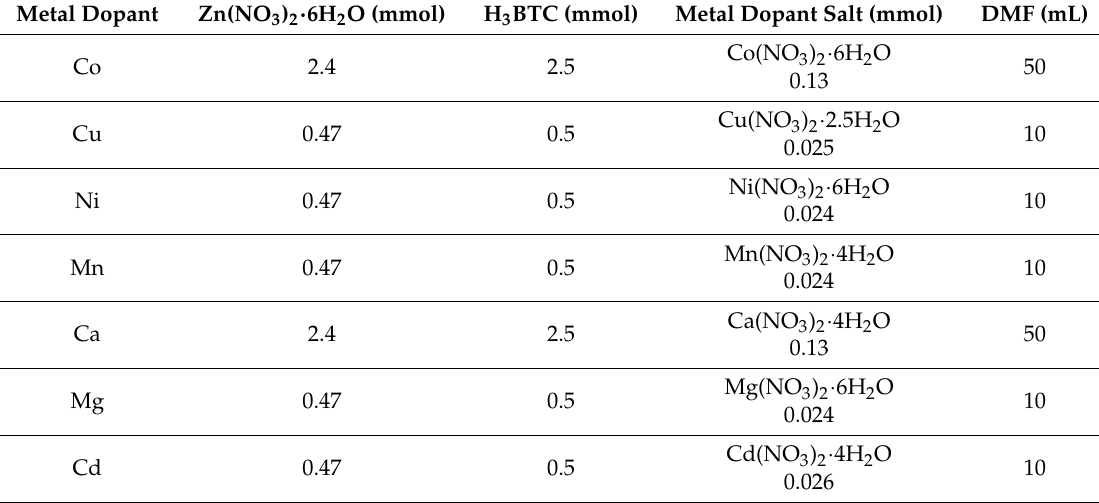
Table 1. Summary of reaction conditions for MOF synthesis: single metal doping {Zn-M-BTC}{Me 2 NH 2+ }.